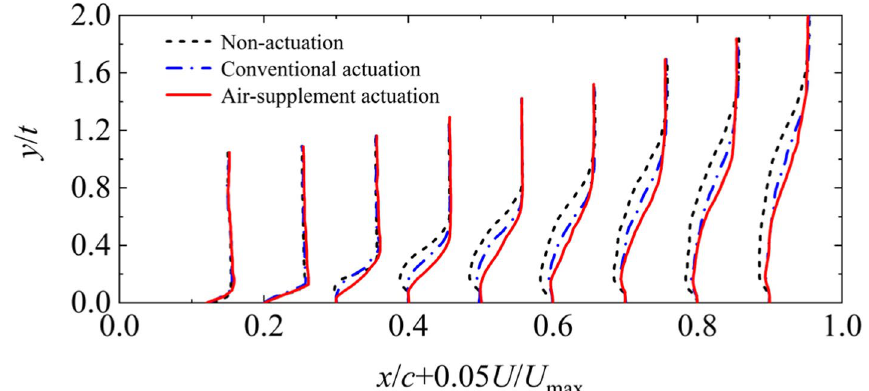
Fig. 16 Velocity profiles of the suction surface under different actuation